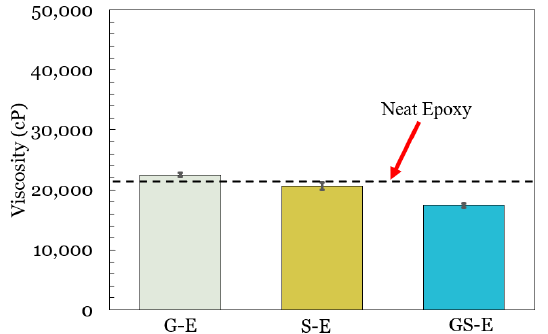
Figure 5. The viscosity of mixtures with different types of nanofillers.